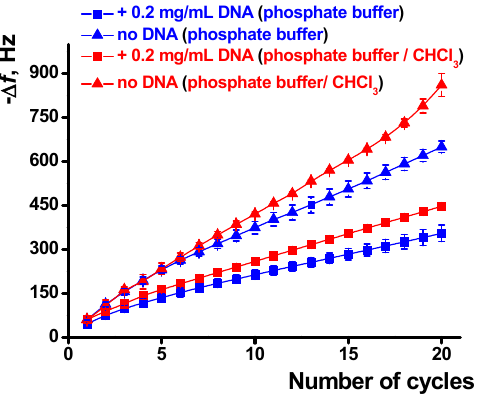
Figure 8. Dependence of the EQCM frequency shift on the number of potential cycles during the poly(Azure A) electropolymerization, average from six QCM chip measurements.